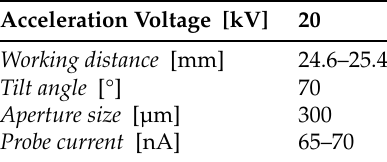
Table 5. SEM parameters used during EBSD acquisition.